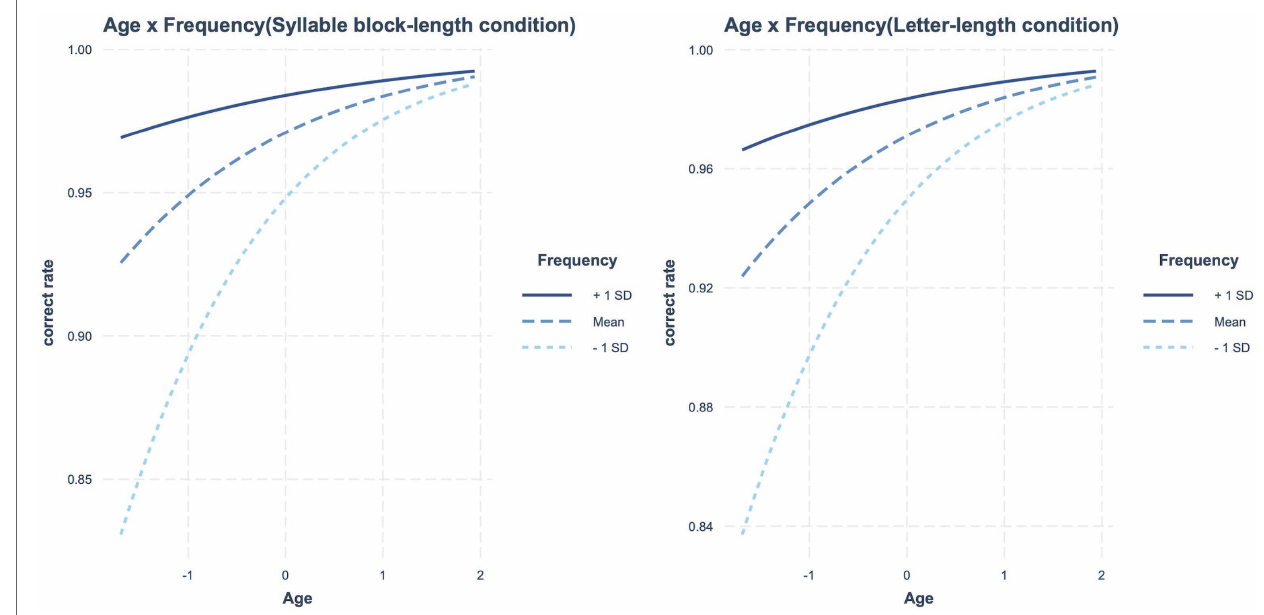
FIGURE 2 | In reading accuracy, significant interaction between age and frequency.